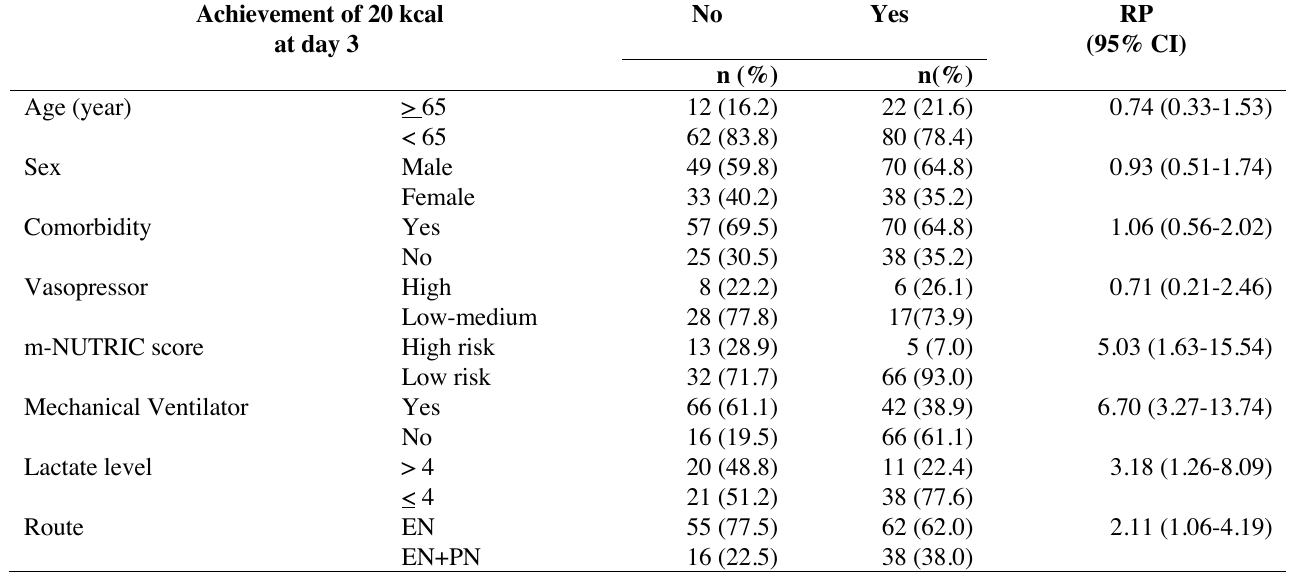
Table 2. Risk factors for achievement of energy target Achievement of 20 kcal